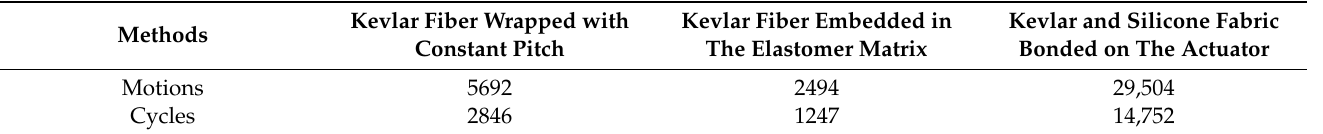
Table 3. Quality control results for the three reinforcement